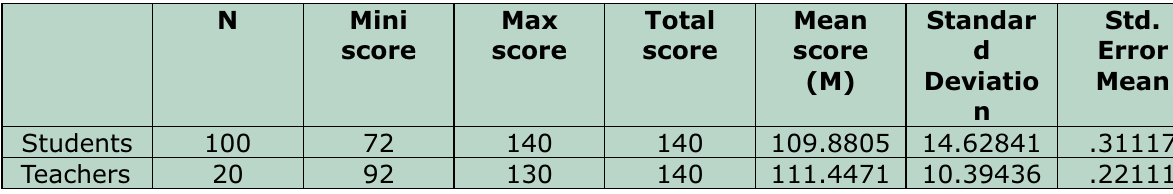
Table-I: Mean scores of self-evaluated and students reported teaching